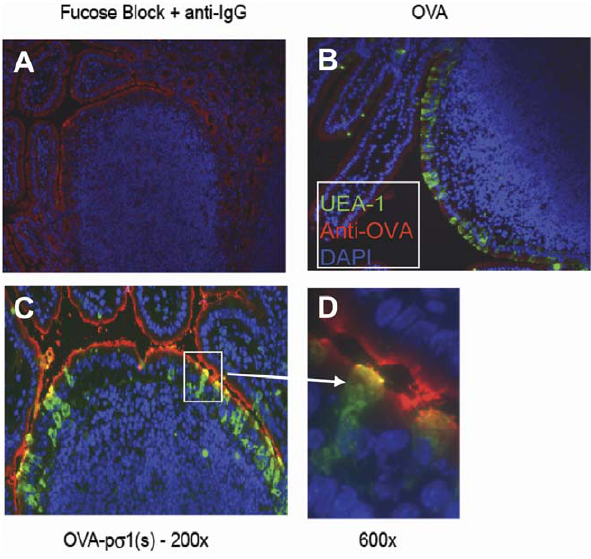
Figure 2. OVA-p s 1(s) retains the ability to bind PP M cells. An ileal loop assay was performed to assess the ability of OVA-p s 1(s) and OVA to bind to PP M cells as determined by co-localization with FITC- UEA-1. A. Fucose block of UEA-1 binding in the presence of biotinylated rabbit IgG and Streptavidin-Alexa H Fluor 594. B. OVA does not co- localize to PP M cells since no OVA could be detected with biotinylated rabbit anti-OVA plus Streptavidin-Alexa H Fluor 594. C. and D. OVA- p s 1(s) co-localizes with UEA-1 in PP M cells as detected with biotinylated rabbit anti-OVA plus Streptavidin-Alexa H Fluor 594 at C. 200 6 and D. 600 6 .